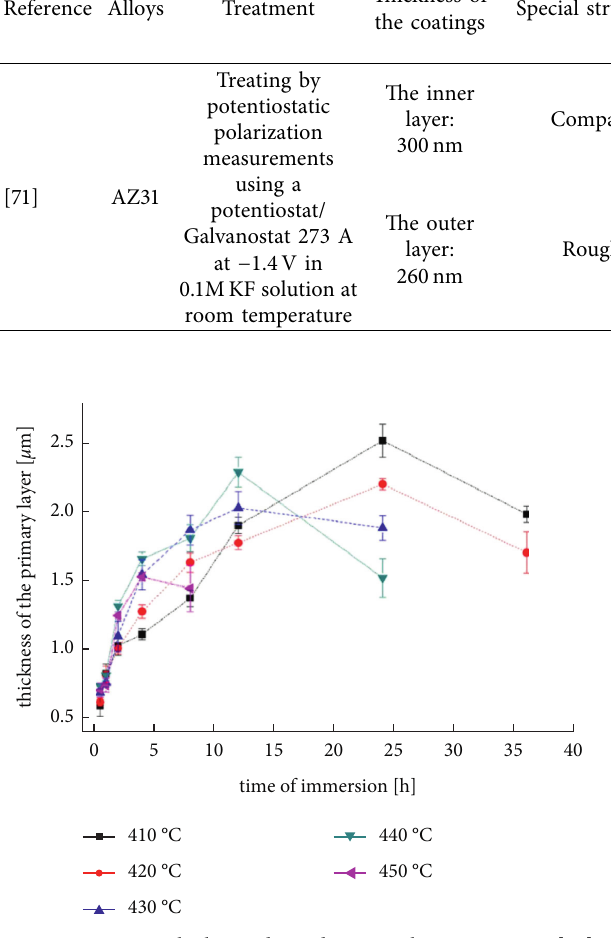
Figure 4: Coating thickness dependence on the coating time [69].